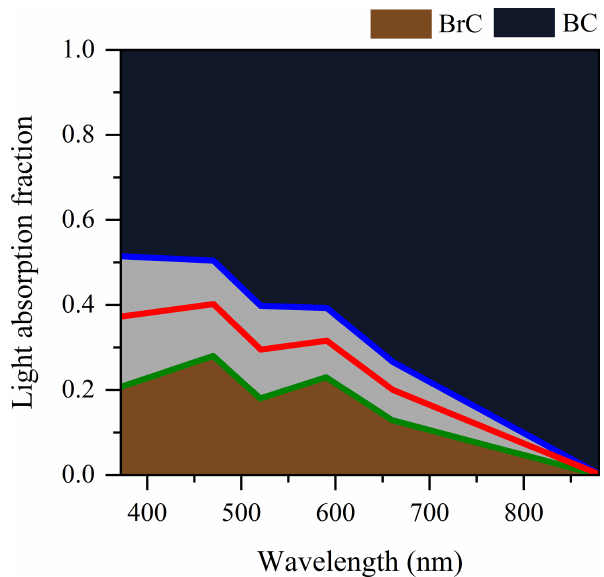
Figure 3. Light absorption fractions at specific wavelengths con- tributed by BrC and BC under different assumptions regarding the absorption Ångström exponent of BC (AAE BC ). The red, blue, and green lines are the dividing lines between BrC and BC light absorp- tion fractions when AAE BC is 1.1, 0.8, and 1.4, respectively. The grey-filled area represents variations in the BrC absorption fraction caused by the uncertainties in AAE BC ( ± 0 .